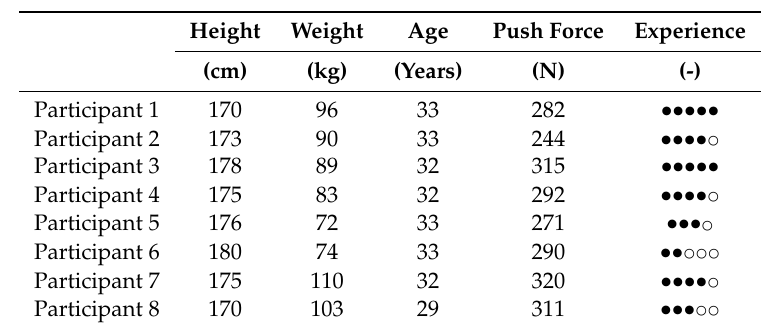
• qualitative assessment of the driving skills of the wheelchair, where the